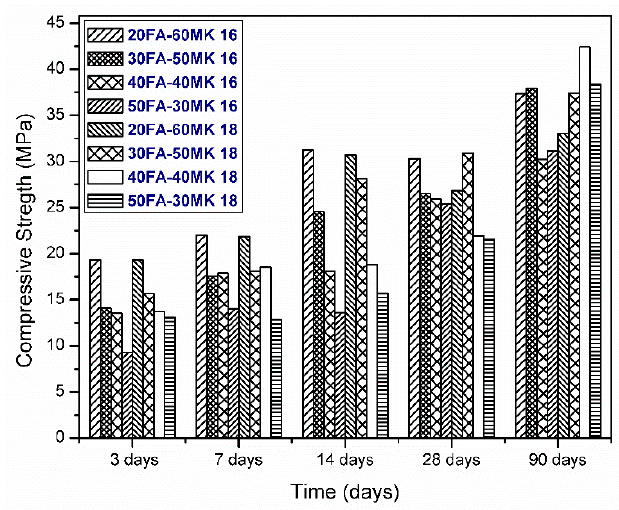
Figure 1. Compressive strength of systems activated with 16% and 18% Na 2 O.